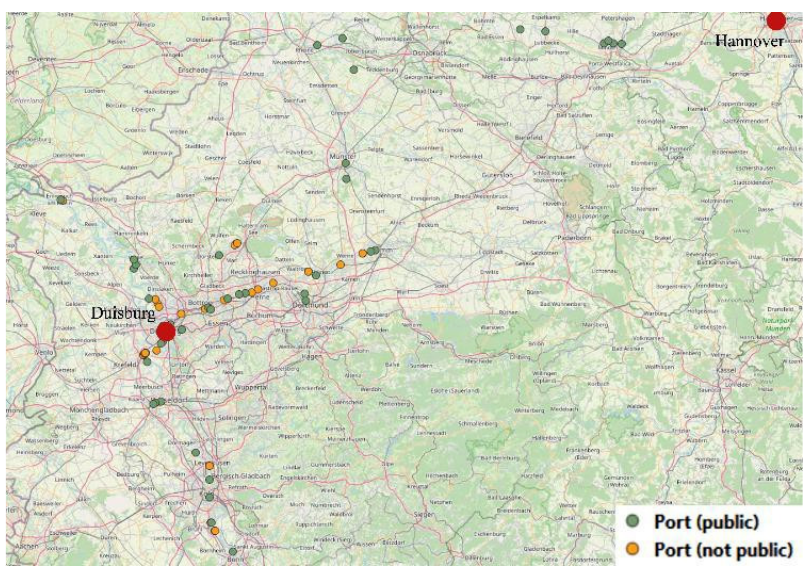
Figure 9. Port locations.